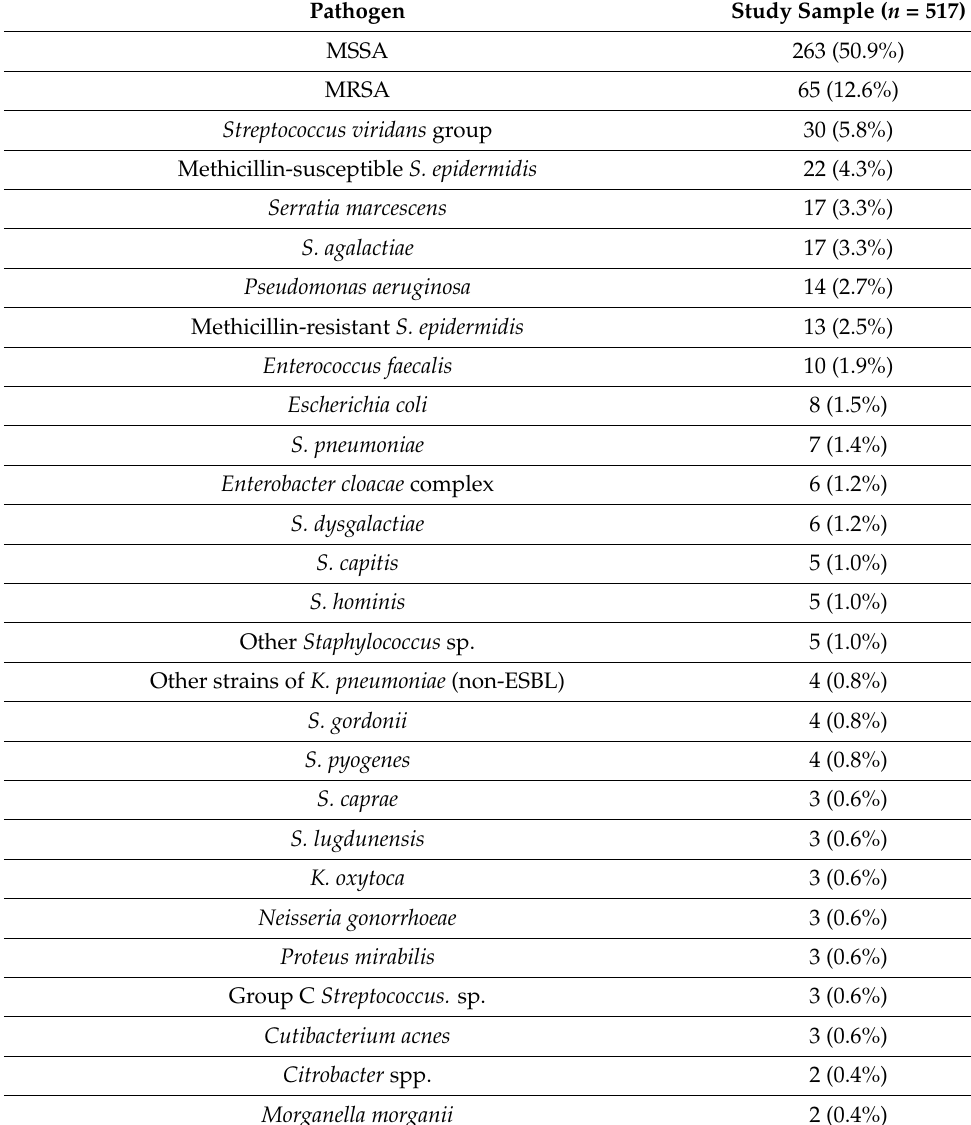
Table 1. Frequency of Organisms Identified During Index